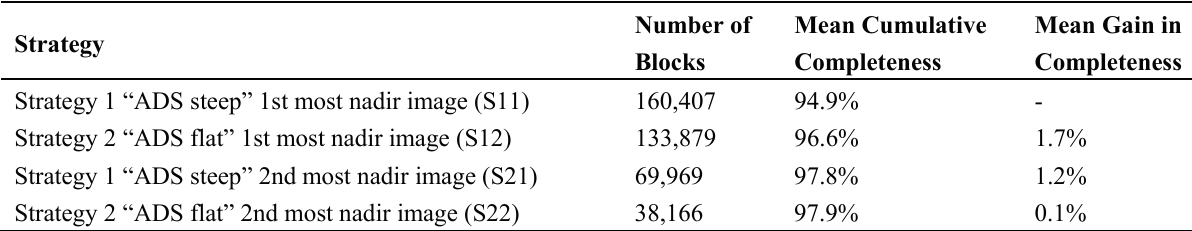
Table 2. Gain in completeness of matched points with the different strategies and image stripes used.